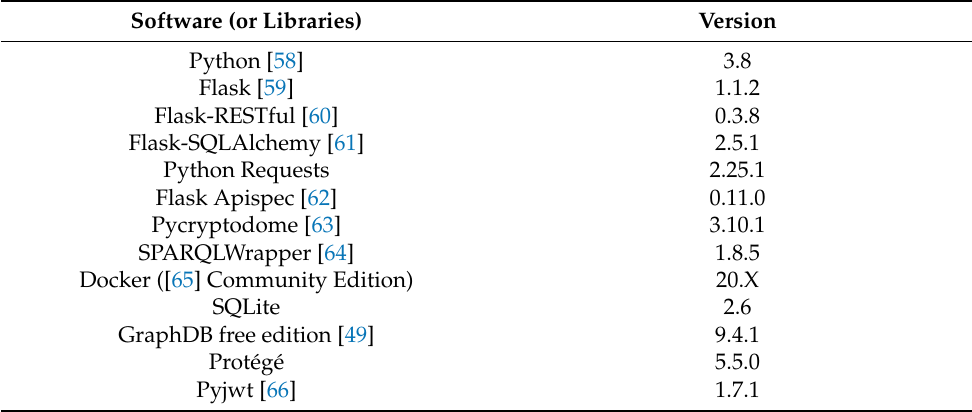
Table 1. List of software (or libraries) that were used in the implementation. Software (or